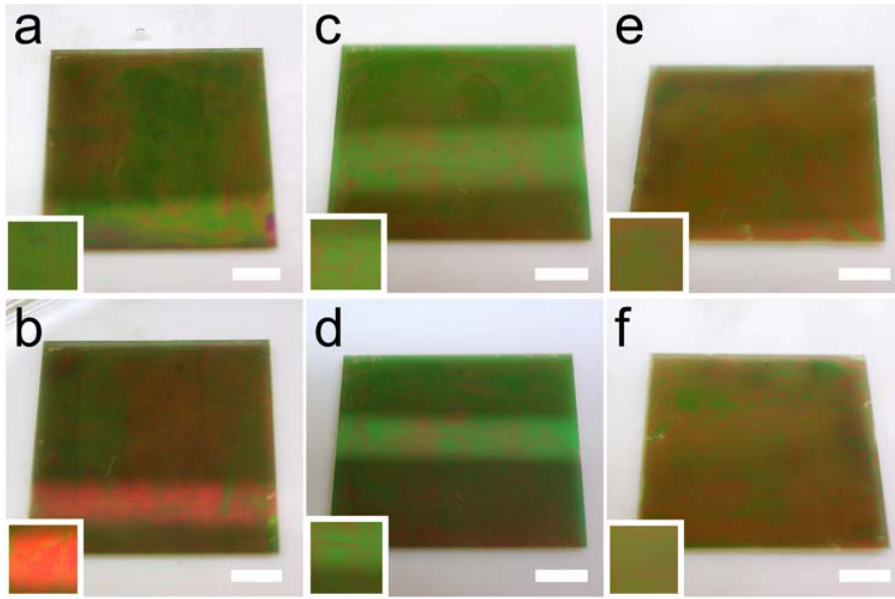
Figure 10. APBA-functionalized microgel etalons show visible color differences when they are soaked in ( a ) 5 mM pH 9 carbonate buffer versus ( b ) a pH 9 carbonate buffer containing 3 mg/mL glucose for 2 hours. Various etalon controls, e.g., ( c , d ) etalons fabricated by exposure to APBA only, and ( e , f ) EDC only, show no significant color change (c, e) before and (d, f) after glucose exposure. Image insets show a cropped image of the approximate center ~1 cm 2 for each etalon, where the etalons were monitored spectrally, to better display the color change. Note, the color intensity ( not the color ) was increased in the inset. Scale bars are ~5